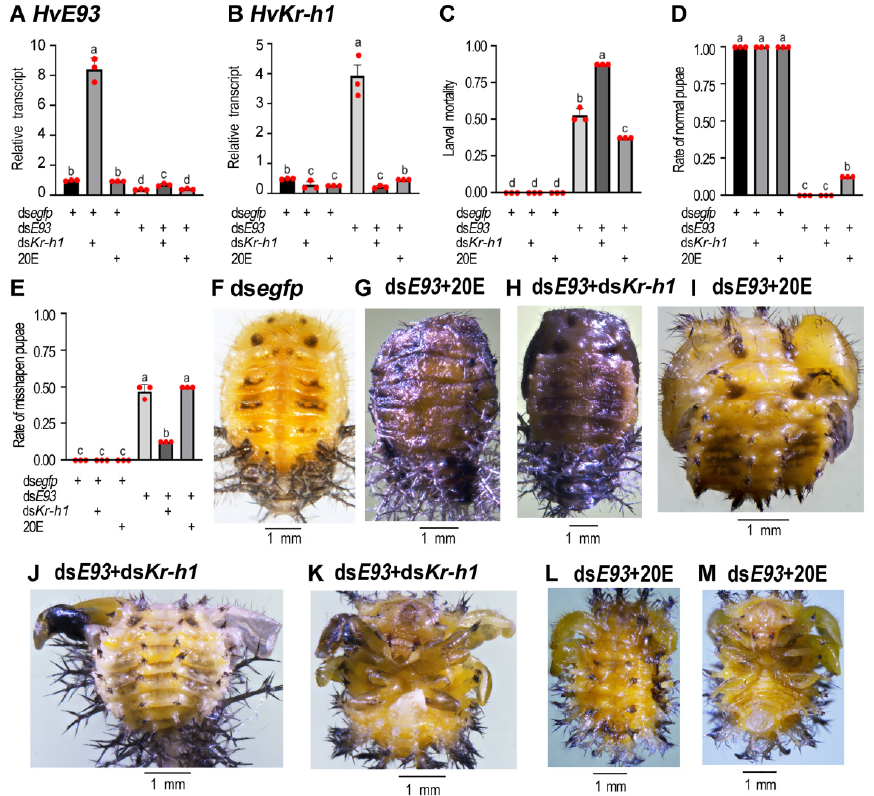
Figure 9. Combined effects of ds E93 and 20E, or ds E93 and ds Kr-h1 , on the development. The newly molted four-instar larvae were treated with ds egfp , ds egfp + ds Kr-h1 , ds egfp + 20E, ds E93 , ds E93 + ds Kr-h1 or ds E93 + 20E. Three days after treatment, transcript levels (2 −ΔΔ CT values) of HvE93 and HvKr-h1 were determined. The rates of arrested larvae, normal and deformed pupae were recorded during a 3-week trial period ( C – E ). Statistical significances ( p value < 0.05, showing by different letters above the columns) between treatment and control (means ± SE) were calculated using analysis of variance with the Tukey–Kramer test. Dorsal ( F – J , L ) and ventral ( K , M ) views of pupae are shown.